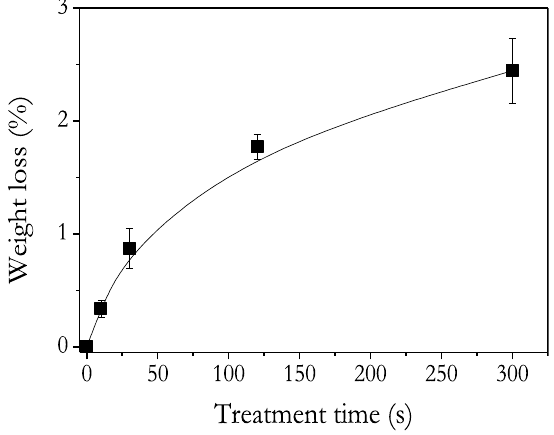
Figure 2. Nasturtium seed weight loss as a function of plasma treatment time.